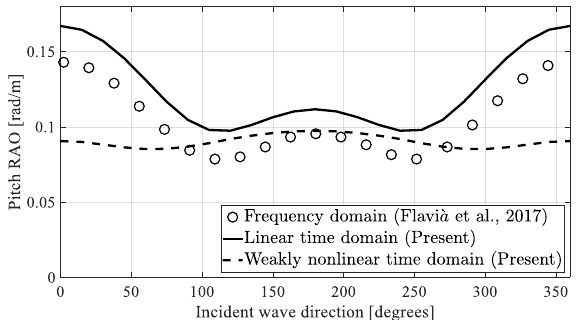
Figure 7. Comparison of pitch RAO of the float according to the incident wave direction ( 𝜔 = 1.4 rad/s).